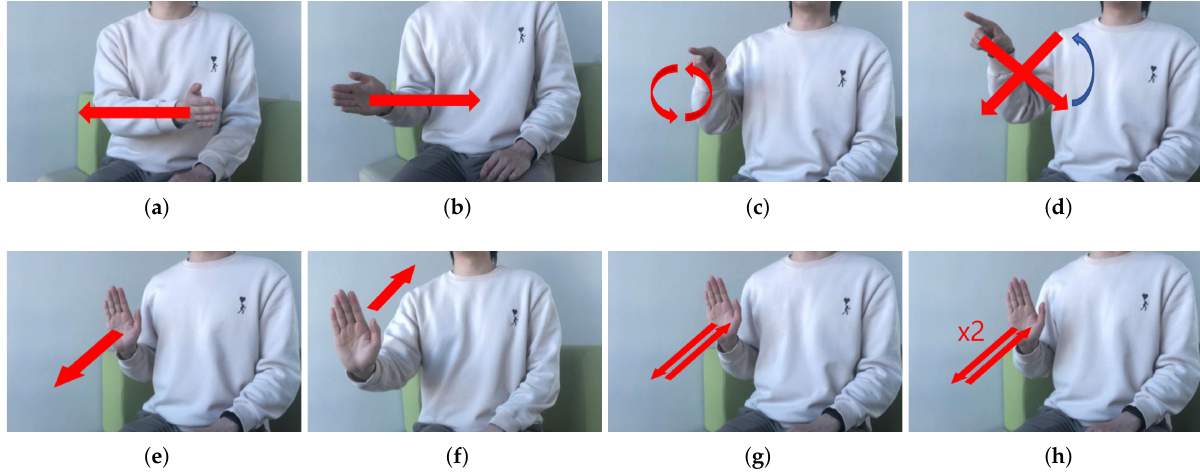
Figure 4. Hand gesture examples: ( a ) Hand swipe from right side to left side (symbol for right); ( b ) Hand swipe from right side to left side (symbol for left); ( c ) Hand swipe shape O (symbol for yes); ( d ) Hand swipe shape X (symbol for no); ( e ) Hand push from body to radar (symbol for stop); ( f ) Hand pull from radar to body (symbol for pull); ( g ) Hand push and pull performed once (symbol for once); ( h ) Hand push and pull performed twice (symbol for